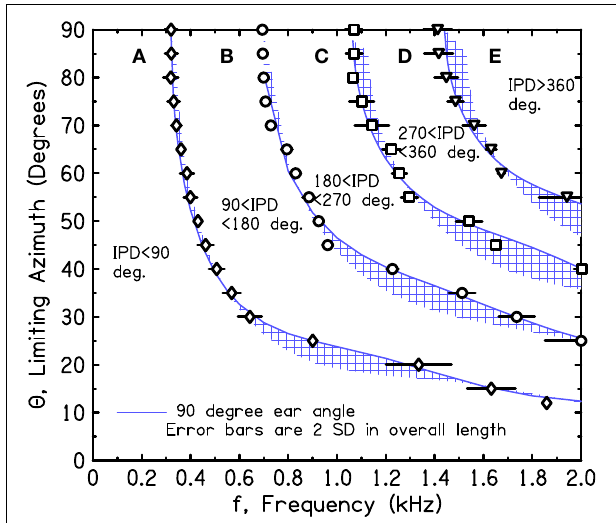
FIGURE 5 | Measured values of frequency and azimuth that lead to IPDs of 90 ◦ , 180 ◦ , 270 ◦ , and 360 ◦ for a perfect sphere. Values were measured in four quadrants using a single source and rotating the sphere. The average of the four is shown together with an error bar two standard deviations in overall length.